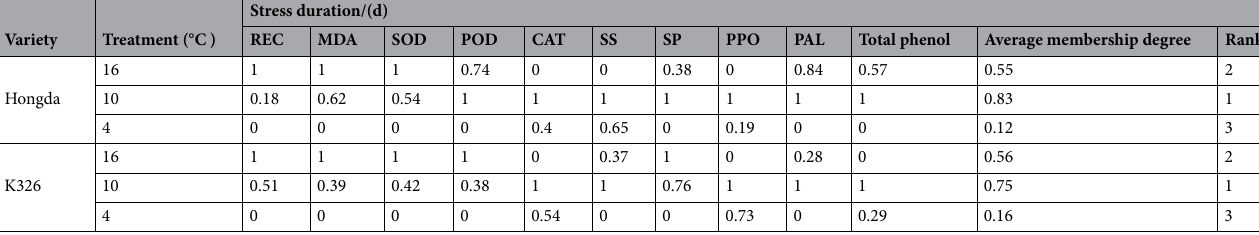
Table 1. Membership function values and comprehensive evaluation of cold resistance indexes of two varieties under different low-temperature